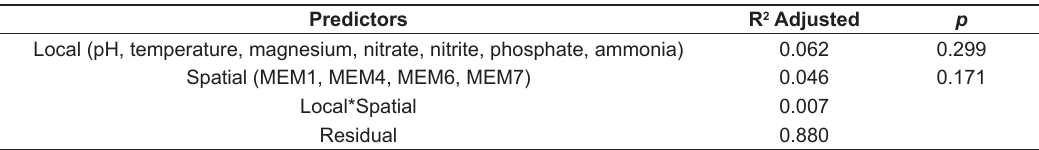
Table 1. Variance partitioning of the biologic matrix explained by local and spatial predictors in the rainy season. MEM = Moran eigenvector map.